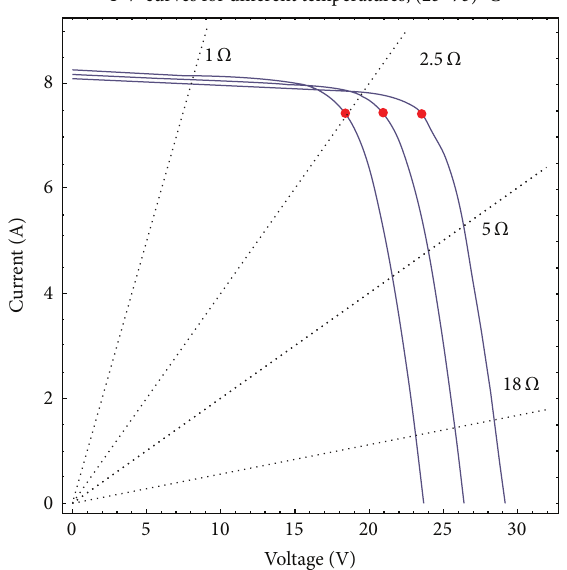
Figure2:WorkingpointofagenericPVpanelatconstantinsolation (1000W/m 2 ) varying temperature and electric